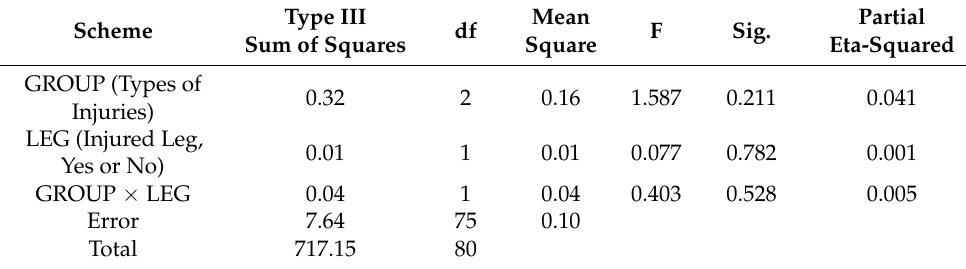
Table 1. Effect of main factors on the level of knee extensor